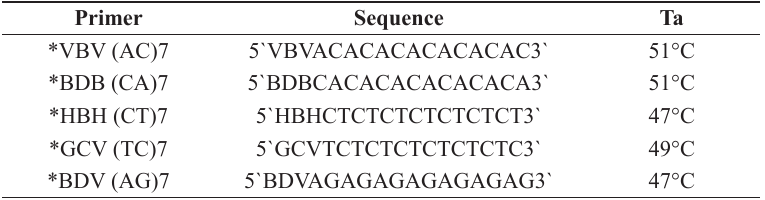
issr primers used to evaluate the 48 jatropha accessions, with their respective sequences and annealing temperatures